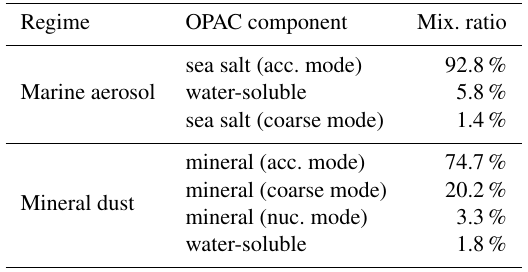
Table 2. OPAC particle type composition of lidar-derived aerosol regimes used in the radiative transfer simulations. Shown percent- ages refer to mass mixing ratios.